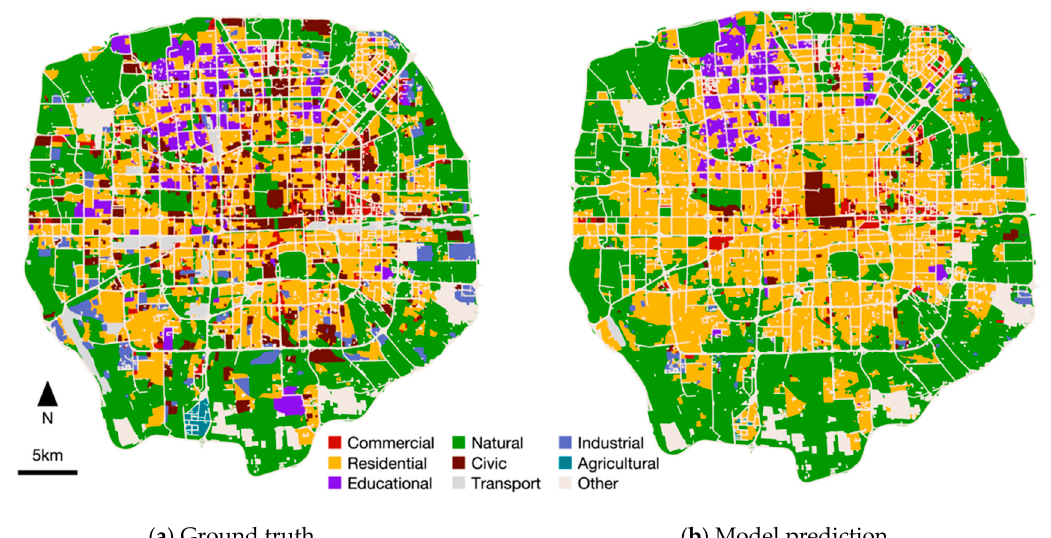
Figure 6. Spatial distribution of land use classification